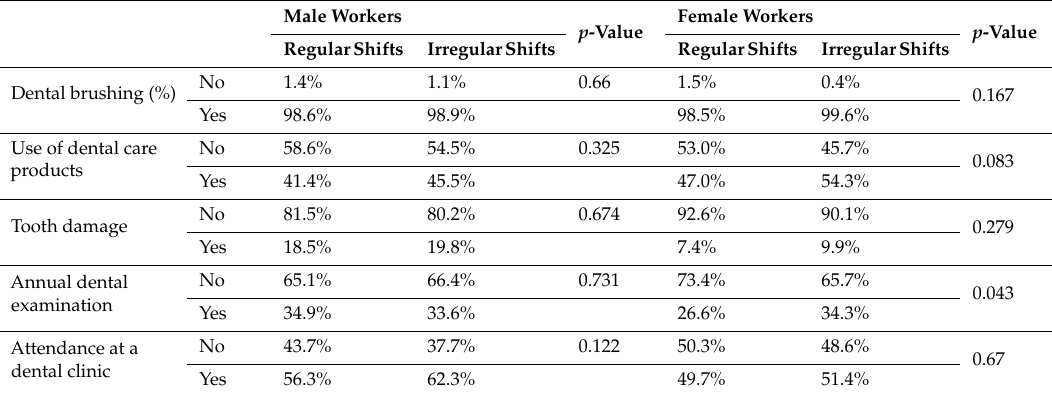
Table 3. Dental health care behaviors according to gender and work pattern.